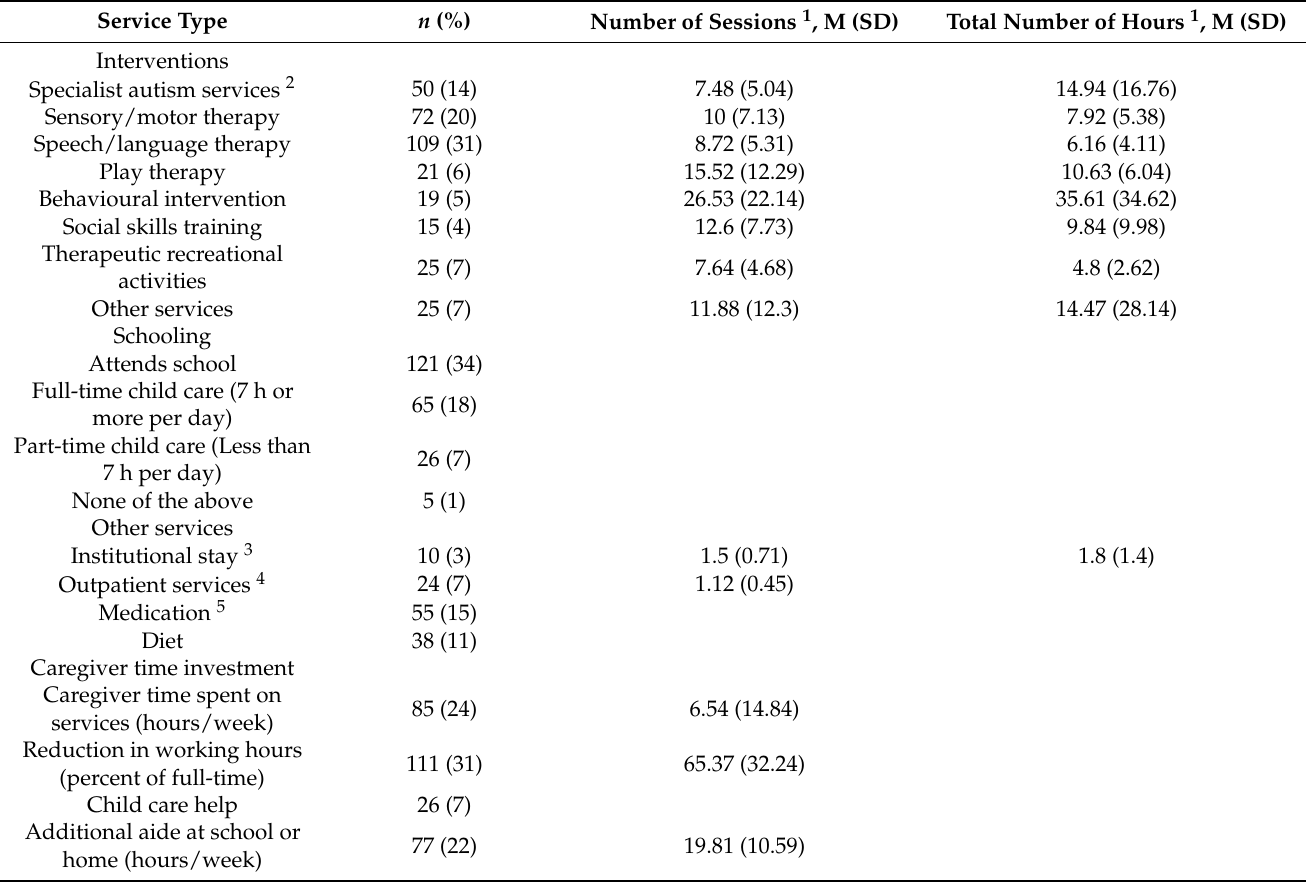
Table 5. Services received by 217 children with ASD in